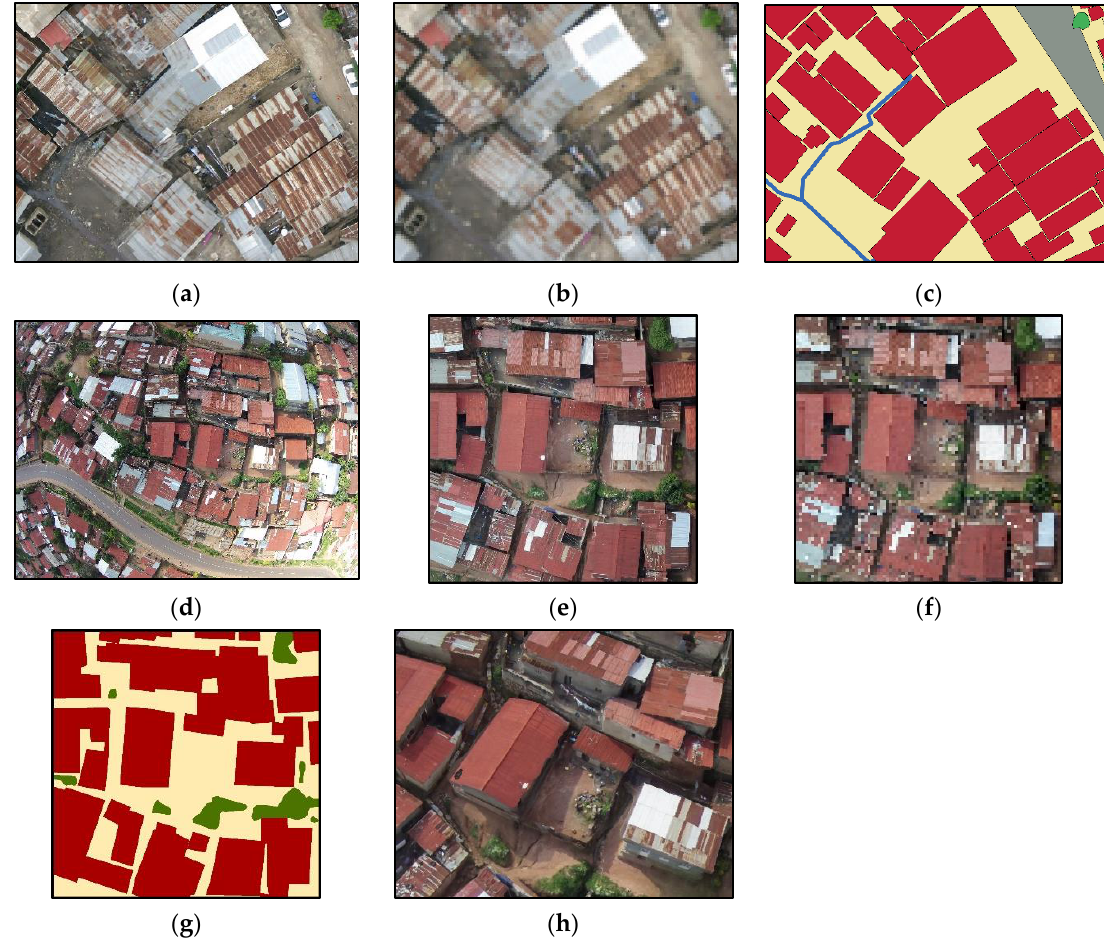
Figure 1. The UAV orthomosaic ( a ), blurred orthomosaic ( b ); and vector map ( c ) images used for the Dar es Salaam questionnaire and the raw UAV image ( d ); UAV orthomosaic ( e ); blurred orthomosaic ( f ); vector map ( g ); and 3D mesh ( h ) images used for the Kigali questionnaire.